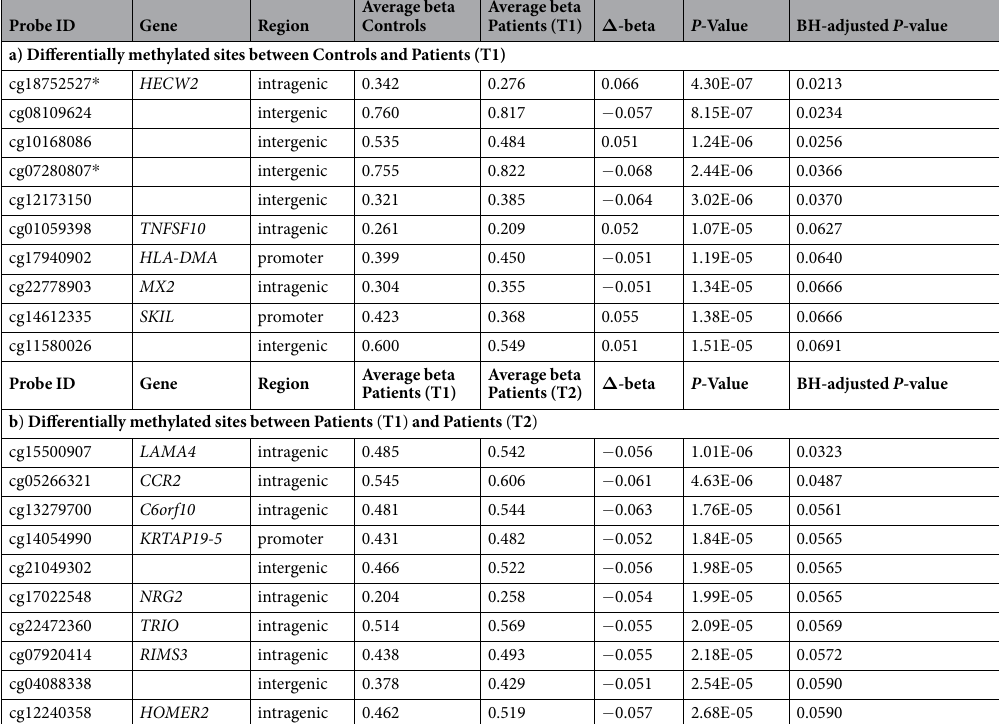
Table 2. Top 10 differentially methylated sites a) between controls and patients (T1) and b) between patients (T1) and patients (T2). Probe IDs marked with an asterisk were validated by pyrosequencing. Abbreviations: Average beta, mean methylation values (%); Benjamini-Hochberg (BH) adjusted P